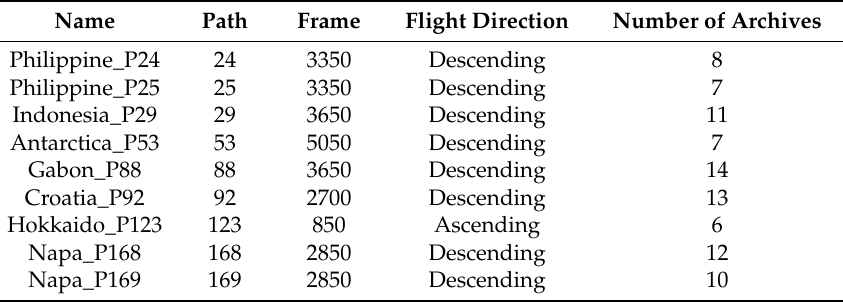
Table 1. List of paths and frames used for misalignment